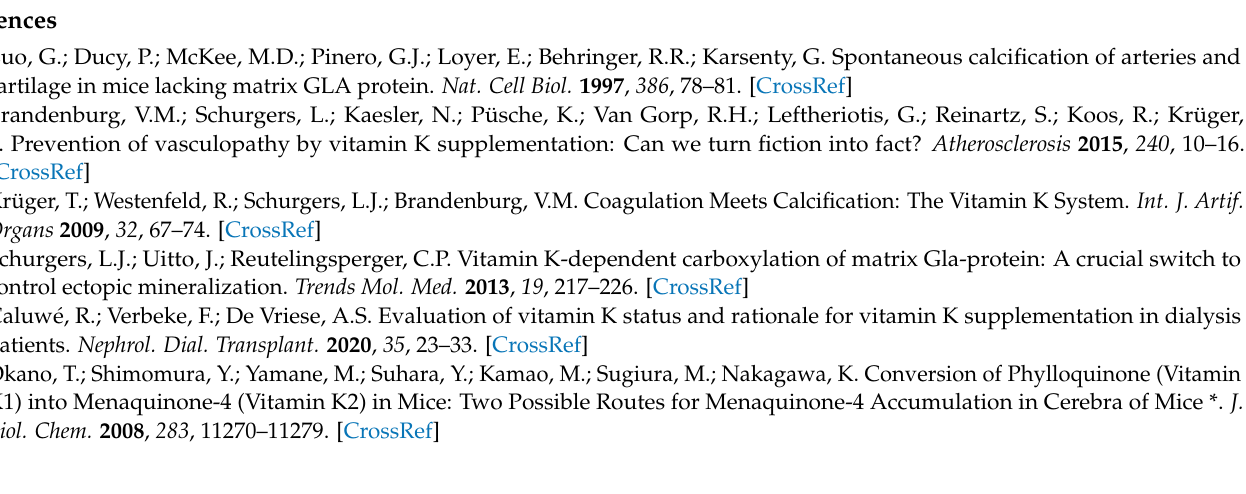
cohort, Supplemental Table S2: dp-ucMGP measurements: patients vs. healthy controls, and Supple- mental Figure S1: dp-ucMGP and PIVKA-II levels of CUA and HD